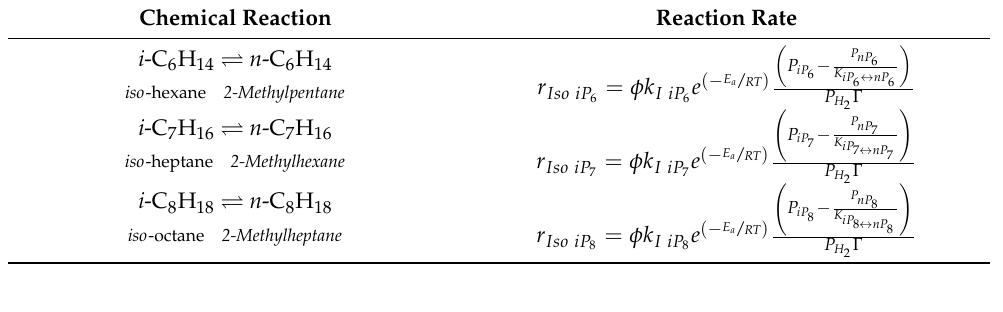
Table 6. Dehydrocyclization of